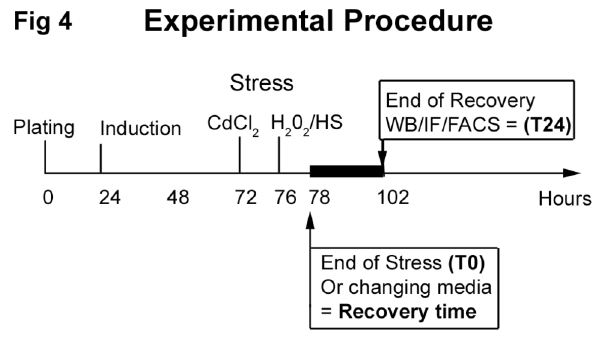
Figure 4. Experimental procedure. Cells were seeded at 3 x 10 3 cells/cm 2 , desmin expression was induced with doxycycline 24 h later. Stresses were introduced 48 h after desmin induction as described in material and methods; untreated cells were manipulated at the same time. Results were monitored immediately after (T ) or after 24 h of recovery time with 0 changing media (T ). 24